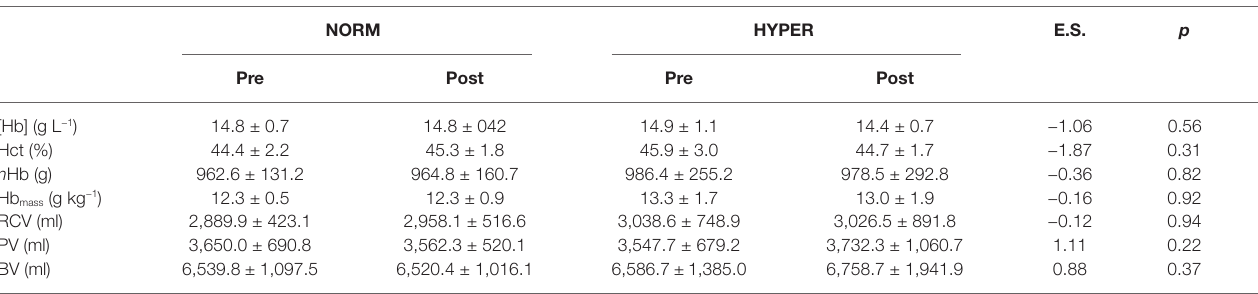
TABLE 2 | Body mass and intravascular volumes before and after training intervention.